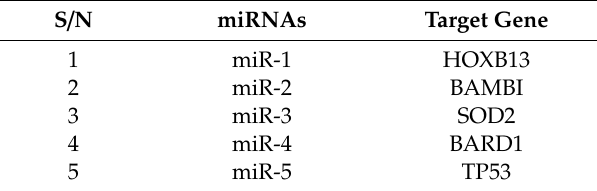
Figure 3. MicroRNA target genes involved in several cancer subtypes. Table 4. The final list of microRNAs and target